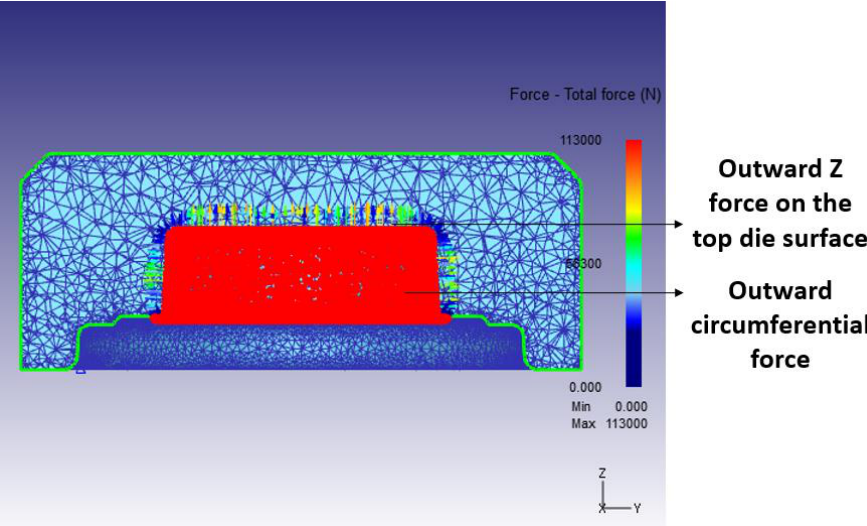
Figure 10. Force interpolation on the top die at flash formation.